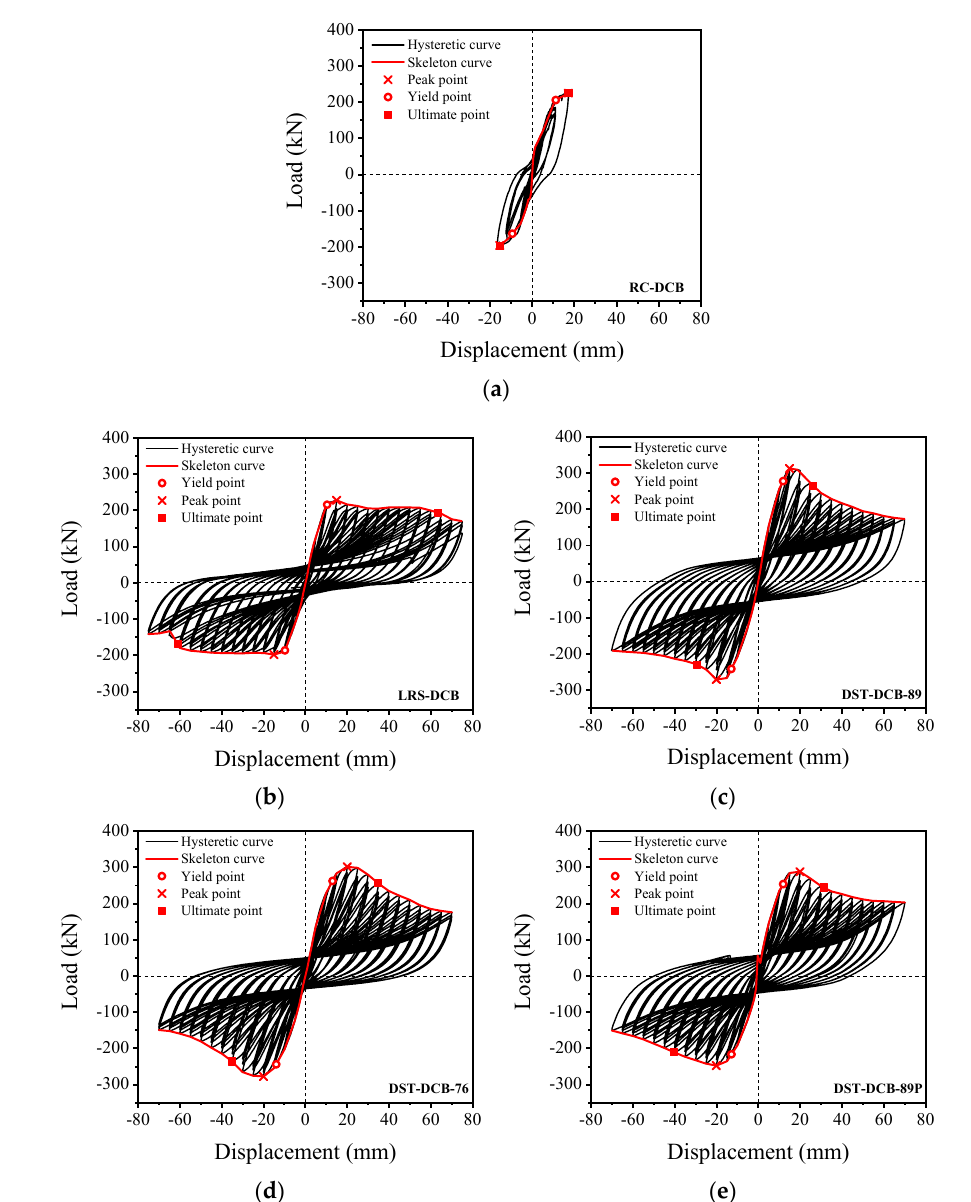
Figure 8. Hysteretic curves of all specimens: ( a ) RC-DCB; ( b ) LRS-DCB; ( c ) DST-DCB-89; ( d ) DST-DCB-76; ( e ) DST-DCB-89P.